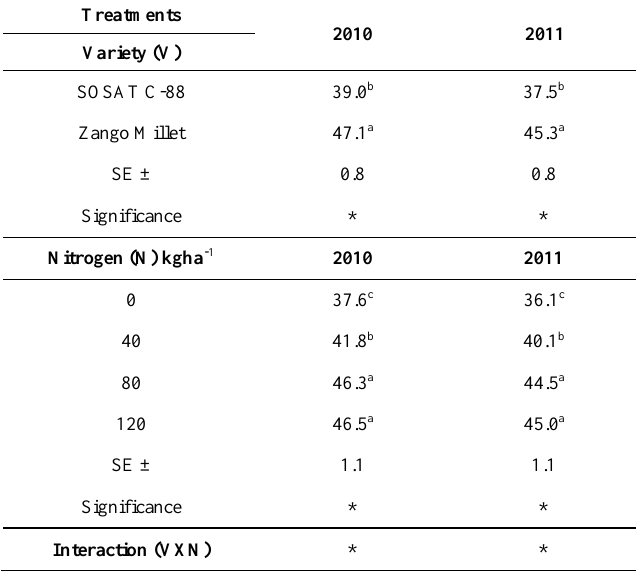
Table 4. Effect of varieties, nitrogen levels on Panicle length (cm) in 2010 and 2011 cropping seasons at Usmanu